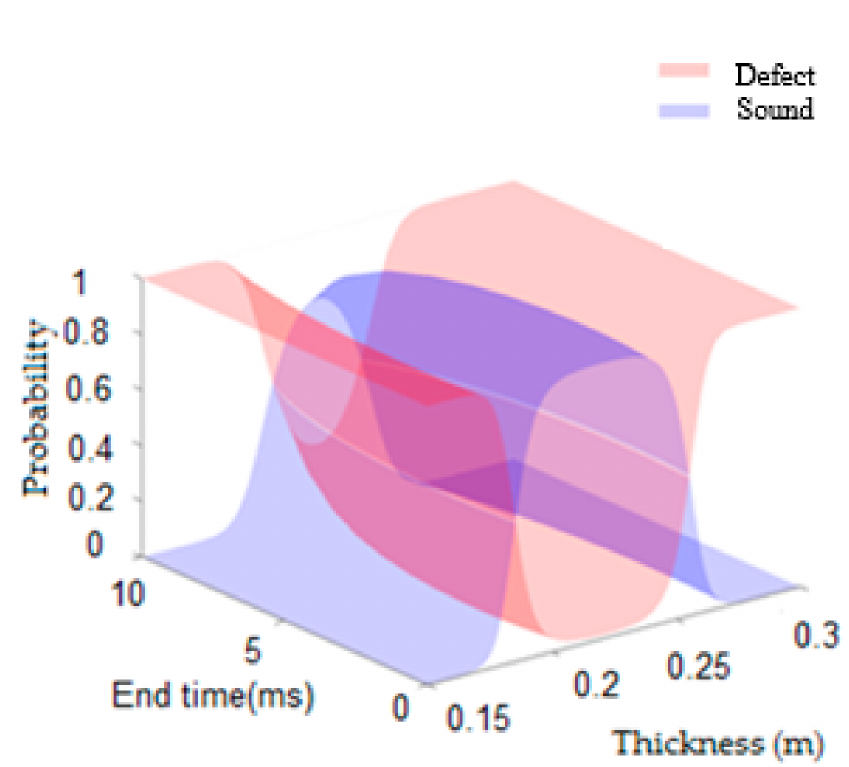
Figure 14. Probability surface to find the relationship between the feature (end time) of IE signals in the time domain and the estimated thickness using frequency domain for slab (8).